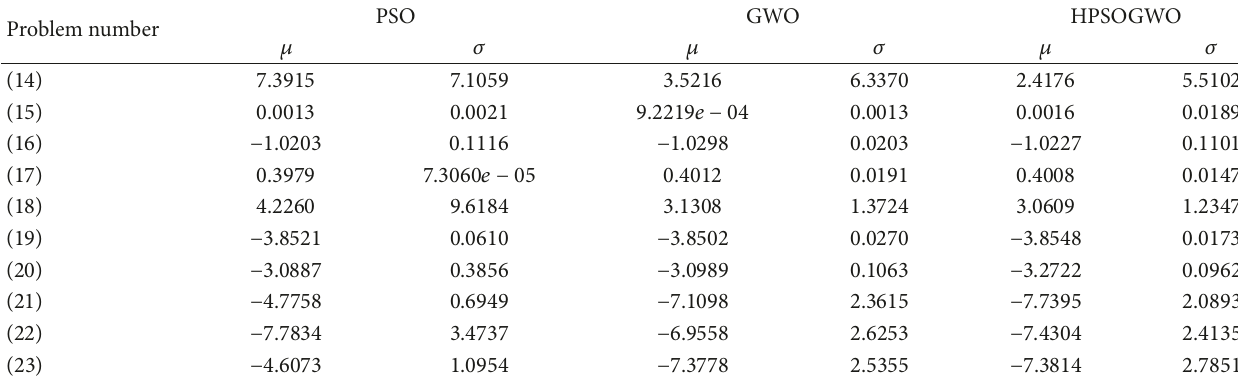
Table 9: PSO, GWO, and HPSOGWO statistical results of fixed-dimension multimodal benchmark functions.